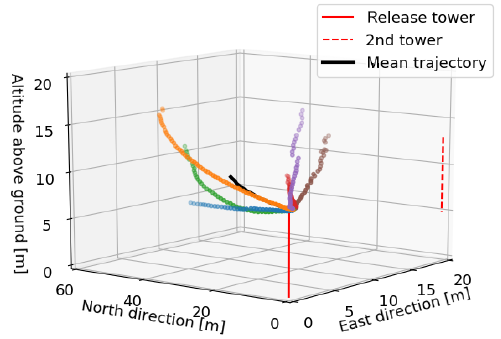
Figure 8. CM trajectories of the six observed puffs and the ensem- ble